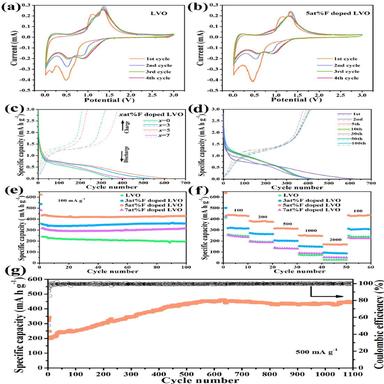
CV curves for (a) undoped and (b) 5 at% F doped samples (sweep rate: 0.02 mV s1 , at 0.013V) of the initial four cycles; initial galvanostatic discharge/charge profiles for (c) different doping levels and (d) a fixed doping level of 5 at% F at given cycle numbers at 100 mA g1 ; (e) cycling performance at 100 mA g1 and (f) rate capability for electrodes of given doping levels; and (g) longtime cycling (at 500 mA g1 for 1100 cycles except for the first five cycles at 100 mA g1 ) for 5 at% F doping.